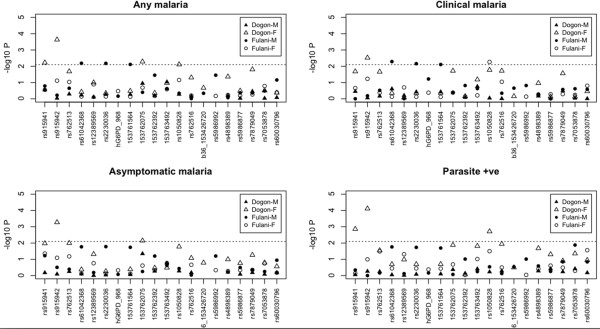
Association analyses for the clinical outcomes.